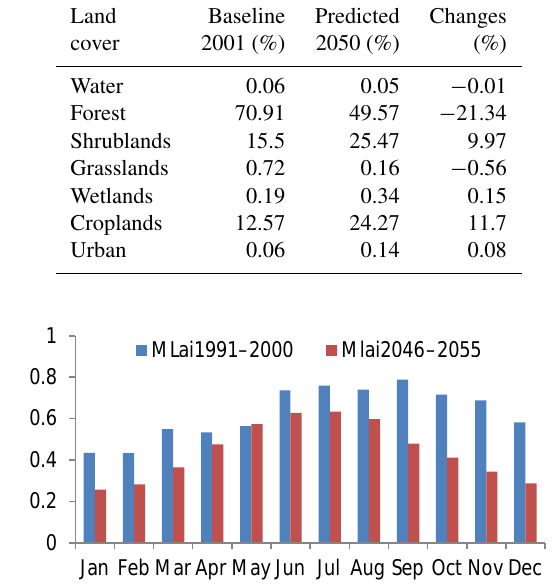
Figure 6. Comparison between current average LAI